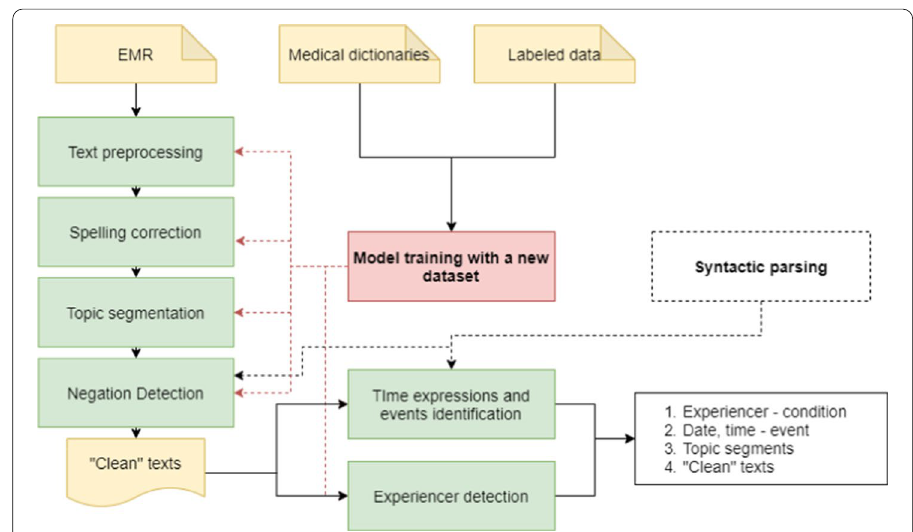
Fig. 3 NLP modules for processing medical texts in